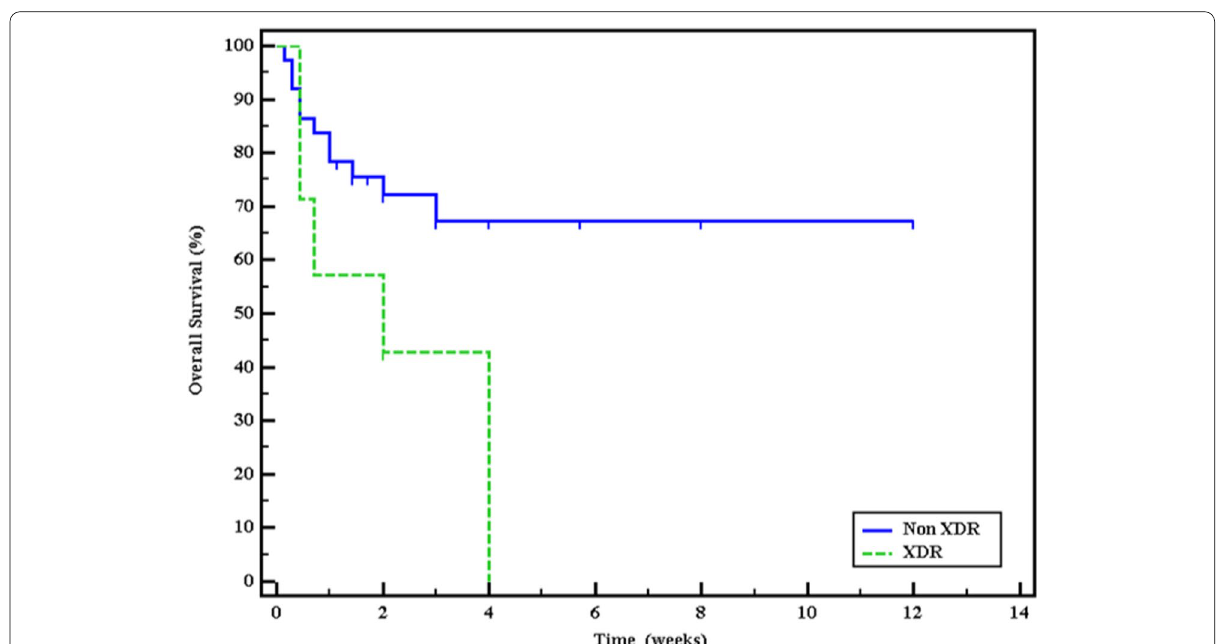
Fig. 2 Kaplan‑Meier survival curve for survival comparing extensive and non‑extensive drug‑resistant klebsiella‑infected patients ( p